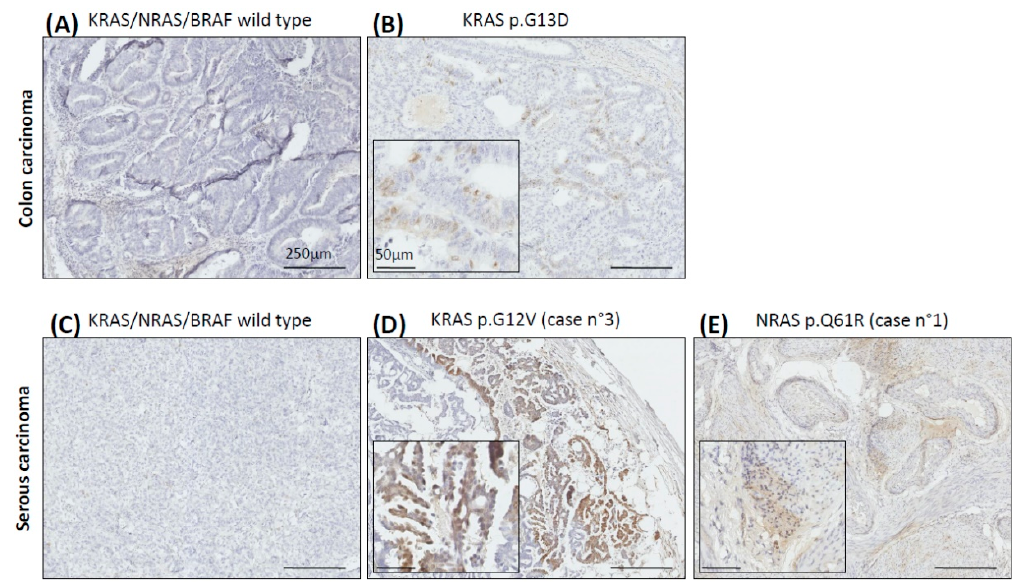
Figure 3. pERK expression in serous and colon carcinoma harboring or not RAS/RAF mutations. Serous and colon carcinoma biopsies from patients were fixed, embedded in paraffin and stained with anti-pERK. ( A , B ) shows pERK expression in colon carcinoma RAS/RAF WT ( A ) or KRAS mutated ( B ). ( C – E ) shows pERK expression in serous carcinoma RAS/RAF WT ( C ), KRAS mutated ( D ) or NRAS mutated ( E ). ( D , E ) are obtained from biopsy of case n°3 and n°1 respectively.